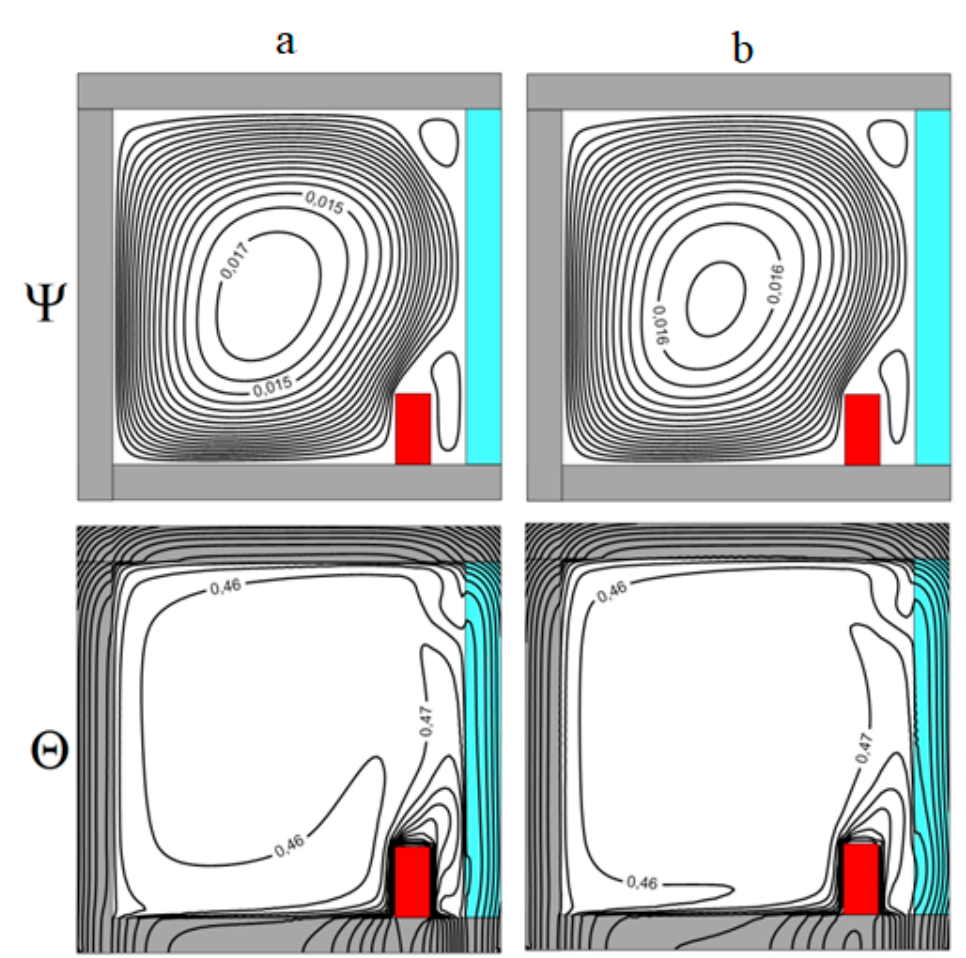
Figure 6. Streamlines Ψ and isotherms Θ for various values of heater surface emissivity at l/L = 0.2: (cid:101) ε h = 0.1 ( a ), (cid:101) ε h = 0.9 ( b